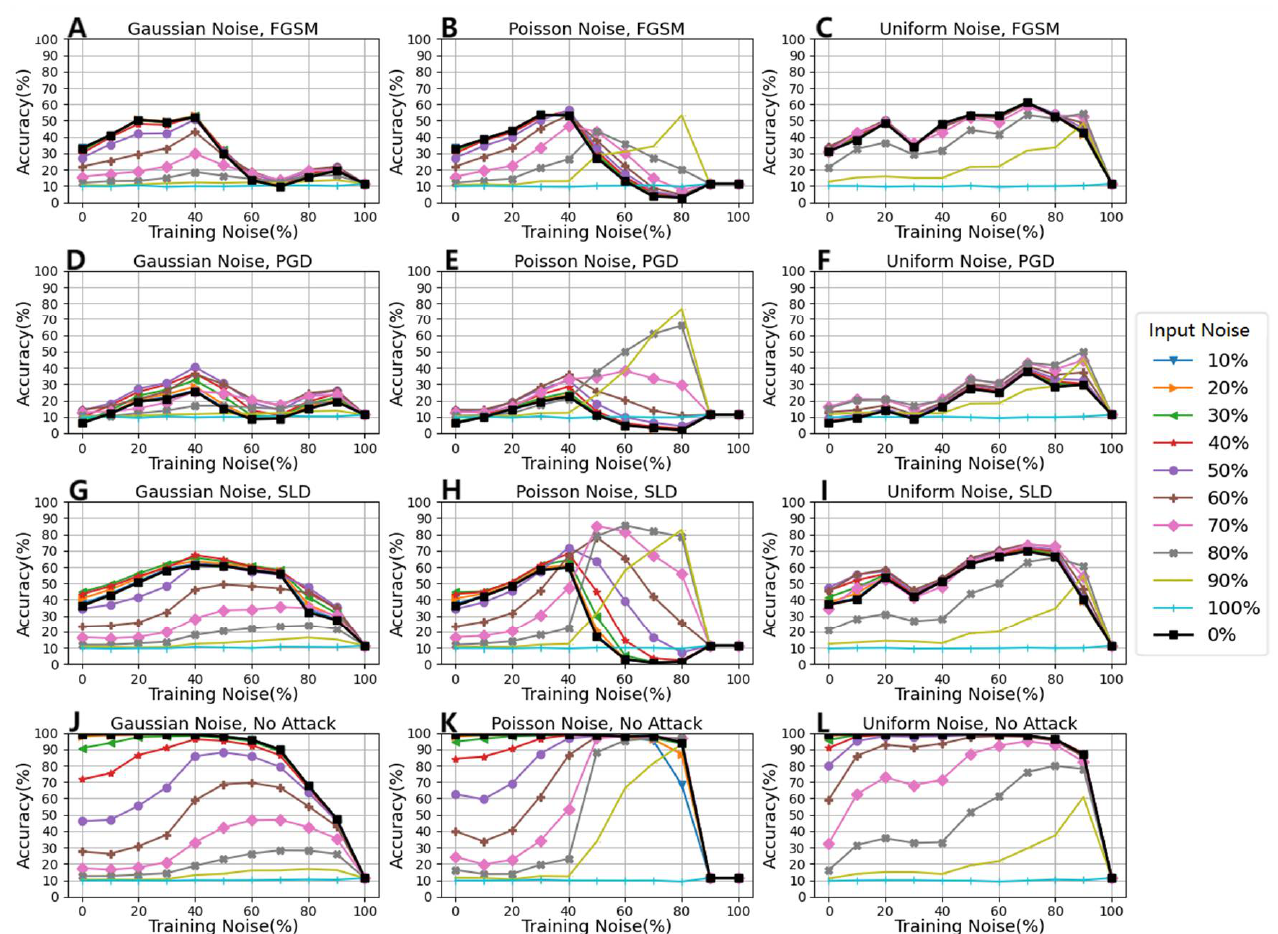
Figure 4. Accuracy of the MNIST at the training dimension. The x axis is the training noise ampli- tude, and the y axis is the accuracy. Different color curves with various symbols indicate different amplitudes of inputting